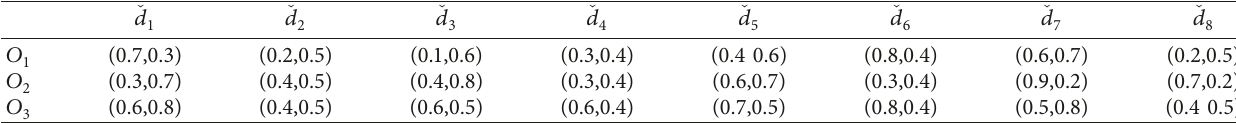
Table 3: PFHS decision matrix for H 3 .